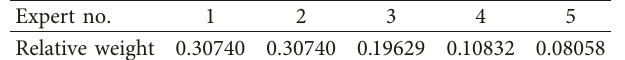
Table 8: Relative weight of the experts. Expert no.